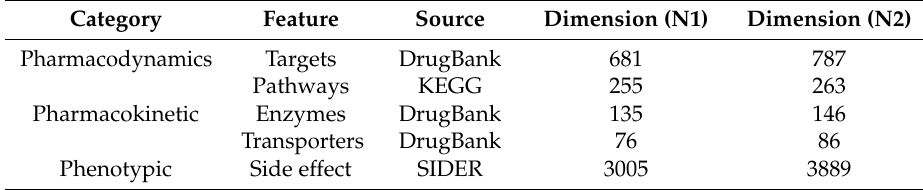
Table 3. The dimensions of different features for the two different negative data